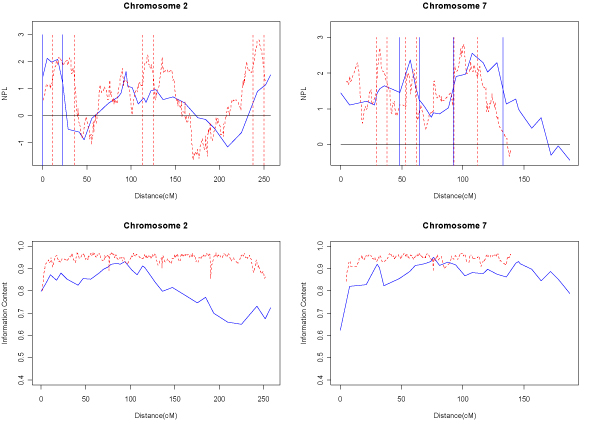
Multipoint nonparametric linkage scores and IC from 1-cM SNP scan for chromosomes 2 and 7. Blue solid line, microsatellites; red dashed line, SNPs. Vertical lines, 1-LOD intervals. IC, information content. Erroneous genotypes were excluded from the analyses.